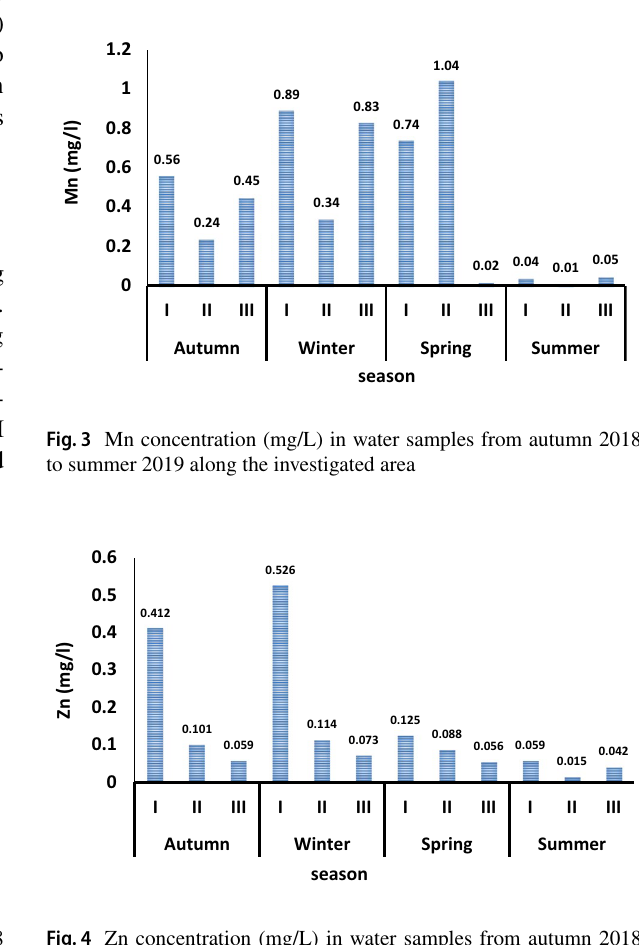
Fig. 4 Zn concentration (mg/L) in water samples from autumn 2018 to summer 2019 along the investigated